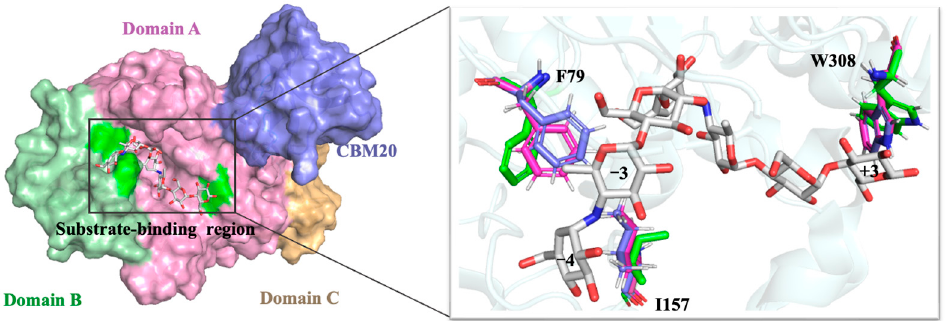
Figure 7. Structural changes of MFA ps near nonreducing end of the substrate. Residues of wild- type MFA ps ., A211C-S214C and S409C-Q412C are represented by green, pink and purple sticks, respectively. The pG7 molecules are shown in stick representation with carbon atoms in gray.